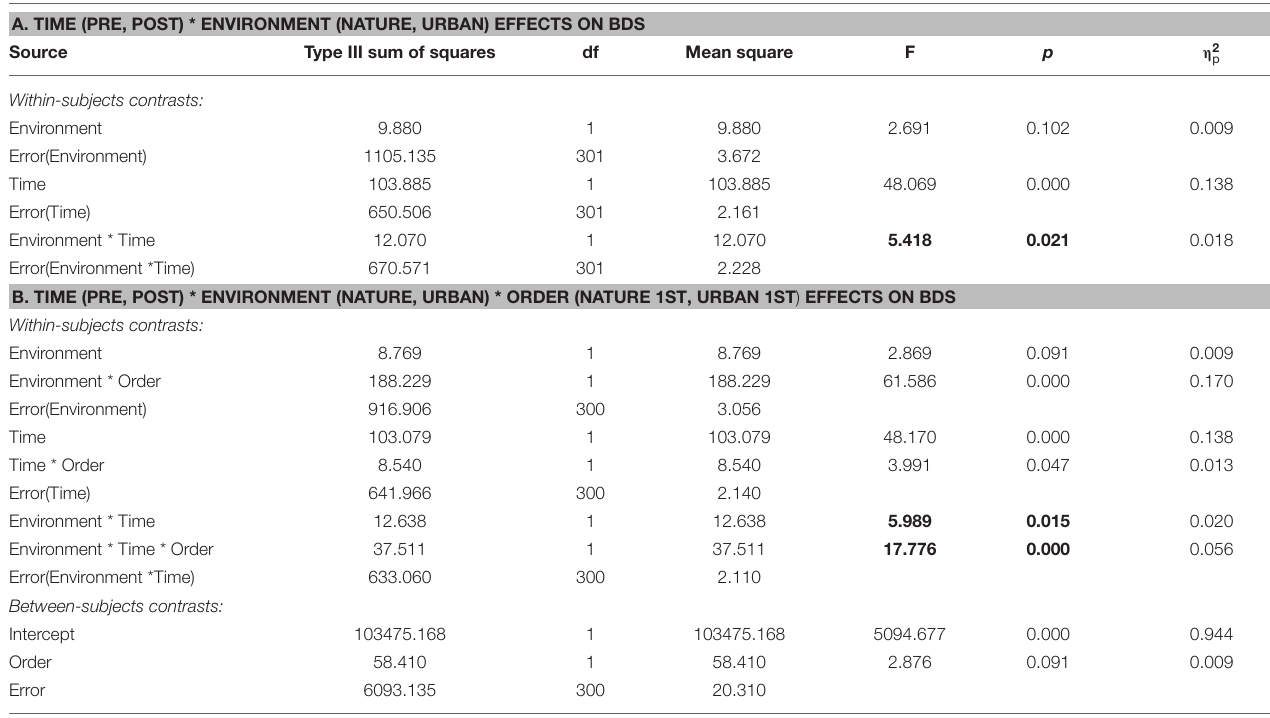
TABLE 4 | Results from ANOVAs on time (pre, post) × environment (nature, urban) effects (A), and time × environment × order (nature 1st, urban 1st) effects (B), on BDS, for studies with environment as a within-subjects factor. A. TIME (PRE, POST) * ENVIRONMENT (NATURE, URBAN) EFFECTS ON BDS